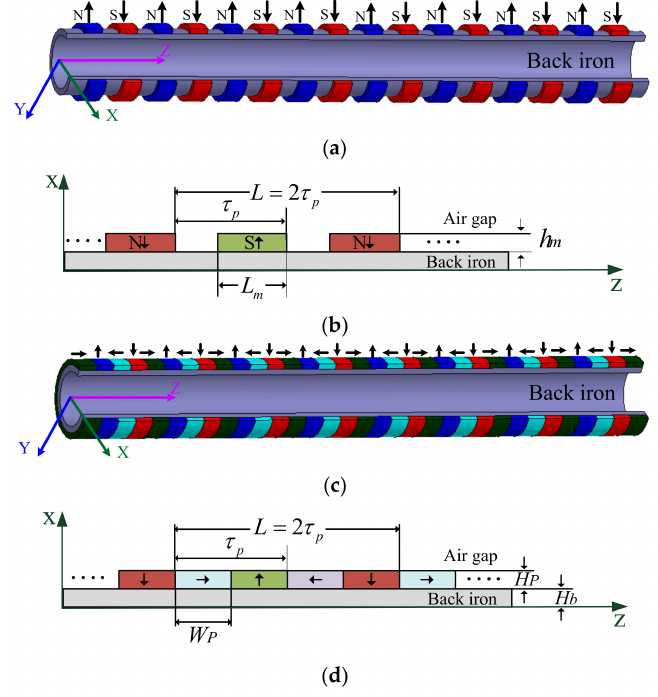
Figure 5. Structures of translators: ( a ) translator with traditional PMs and ( b ) its two-dimensional structure and a ( c ) translator with Halbach PM arrays and ( d ) its two-dimensional